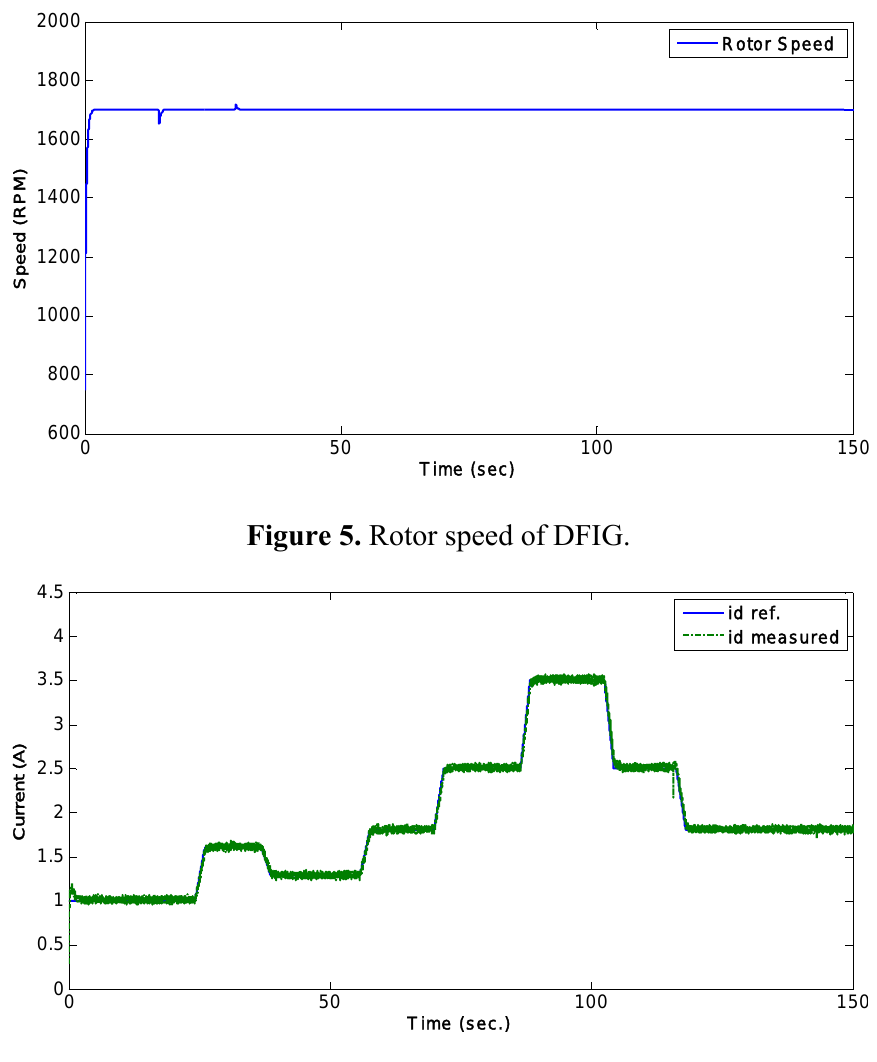
Figure 6. Response of the controlled rotor d